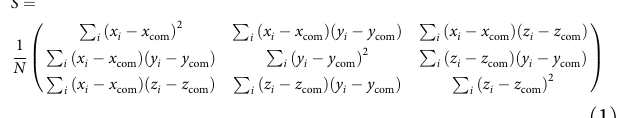
Figure 10a is a plot of the average diameter of the clusters (2 × R G ) on the surface of the NPs. The outcomes reveal the sizes of the NPs in the fi rst 3 nm of both the high- and low-concentration samples. The size of the clusters diverges in the range of 3 – 9 nm from the surface of the NPs, where it appears that the larger clusters formed in the high-concentration solution.